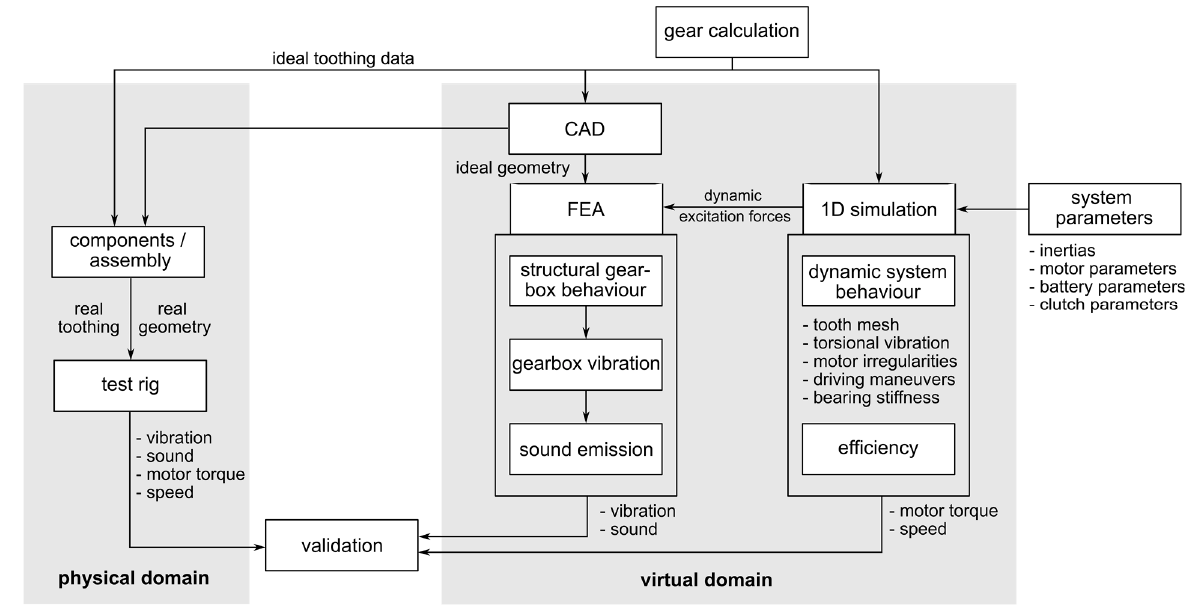
Figure 3. Model implementation.